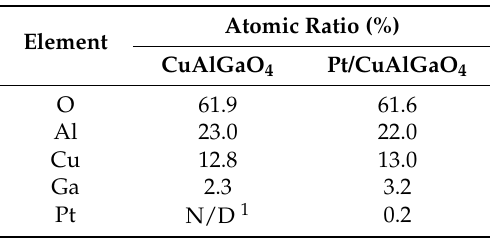
Table 2. Energy dispersive spectroscopy (EDS) analysis for element compositions of CuAlGaO 4 and 1 wt % Pt/CuAlGaO 4 photocatalysts.